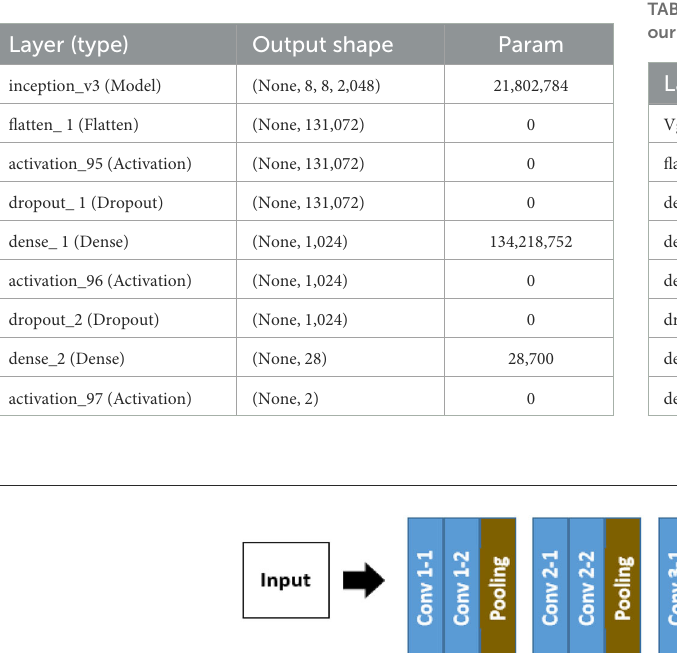
TABLE 2 Hyperparameter details used in the Inception V3 model according to our dataset.